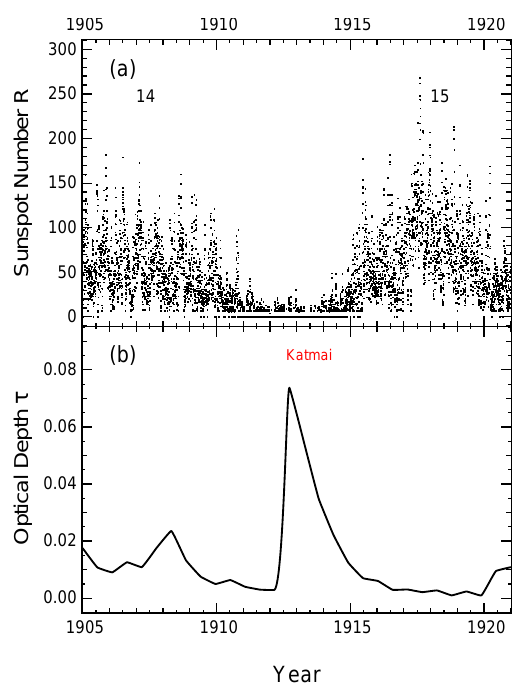
Fig. 3. (a) Time series diagram for the daily sunspot number R for the time period of early SAO observations (1905–1921), spanning solar cycles 14 and 15. (b) Absorption by stratospheric aerosols (expressed as the smoothed optical depth τ at 550nm in the North- ern Hemisphere, Sato et al., 1993) during the same period of time, showing that the solar minimum between cycles 14 and 15 coincides with high levels of volcanic aerosols from the eruption of Katmai in 1912. Please note the change in scale for the optical depth as com- pared to Fig.